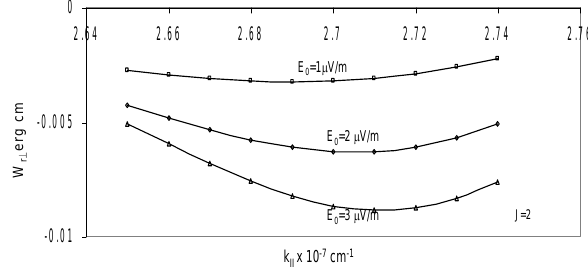
Fig. 5. Variation of growth rate ( γ / (cid:127) i ) versus wave vector k II cm − 1 for different values of parallel electric field E 0 , and distribu- Fig:-2 Variation of growth rate( γ / Ω i ) versus ave vector k II cm -1 for different values of parallel electric field E 0 ,and distribution index Fig. 5 Variation of growth rate ( γ / Ω ) versus wave vector k i II cm-1 for different values of parallel electric field J=1. tion index J=1. E 0 , and distribution index J=1.